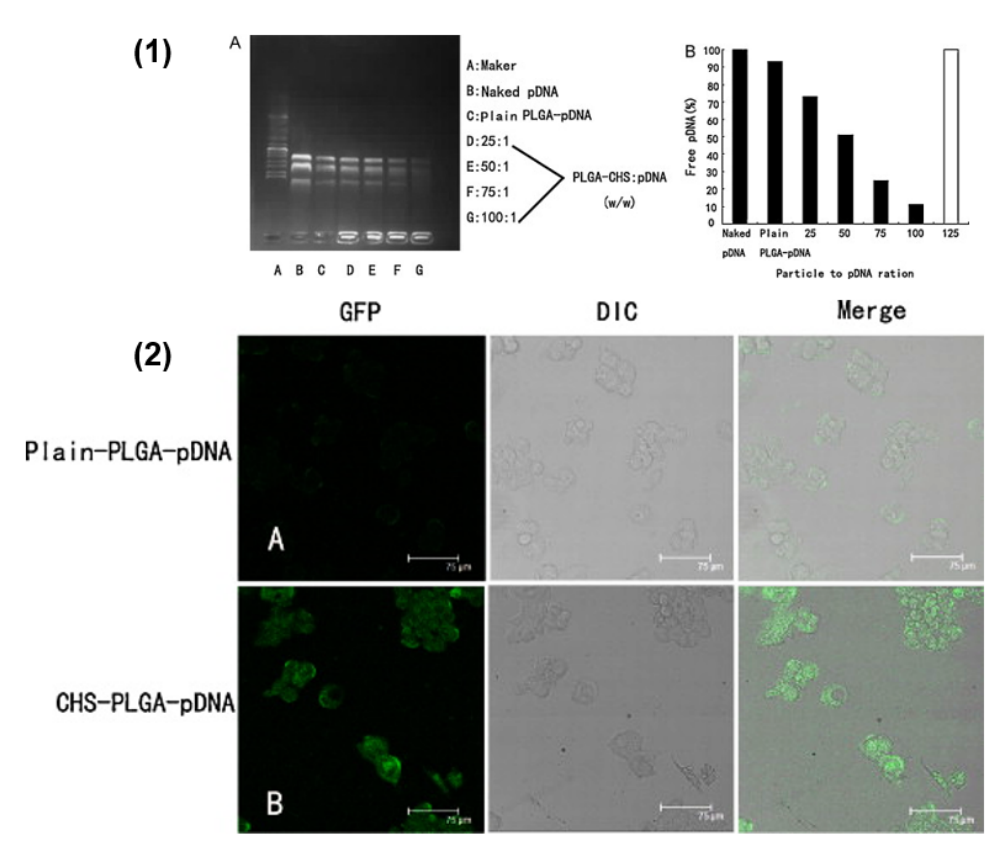
Figure 2. ( 1 ) PLGA–CHS nanoparticle binding efficiency and loading capacity to adsorb pDNA. ( A ) PLGA–CHS–pDNA complexes with increasing amounts of PLGA–CHS NS were prepared and analyzed for pDNA immobilization ability. Electrophoresis was carried out using 1% agarose gel in TAE buffer containing 0.5 µ g/mL ethidium bromide at pH 8. ( B ) The amounts of free DNA were related to naked pDNA (100% mobile) run on the same gel. To quantify the pDNA-immobilization ability, the PLGA–CHS NS/pDNA ratios ( w / w ) required for 100% immobilization are compared in this graph (solid bars = percentage of free DNA; white bars = 100% immobilization). ( 2 ) Confocal laser microscopic images of HepG2.2.15 cells following 48 h transfection with ( A ) plain-PLGA–pDNA NS and ( B ) CHS–PLGA–pDNA NS. Scale bar = 75 µ m (reproduced with permission from [76], © Elsevier B.V. Ltd.